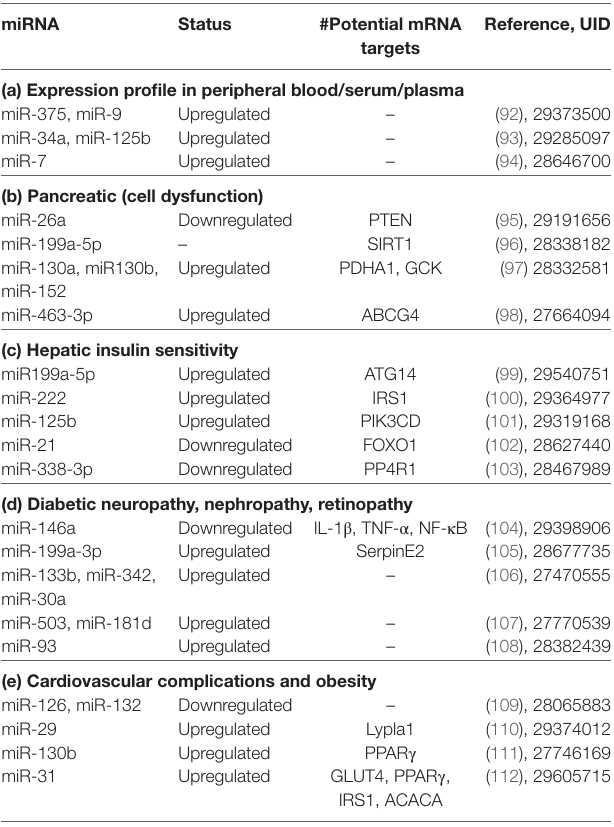
TABLe 1 | miRNAs implicated in T2DM and associated complications.